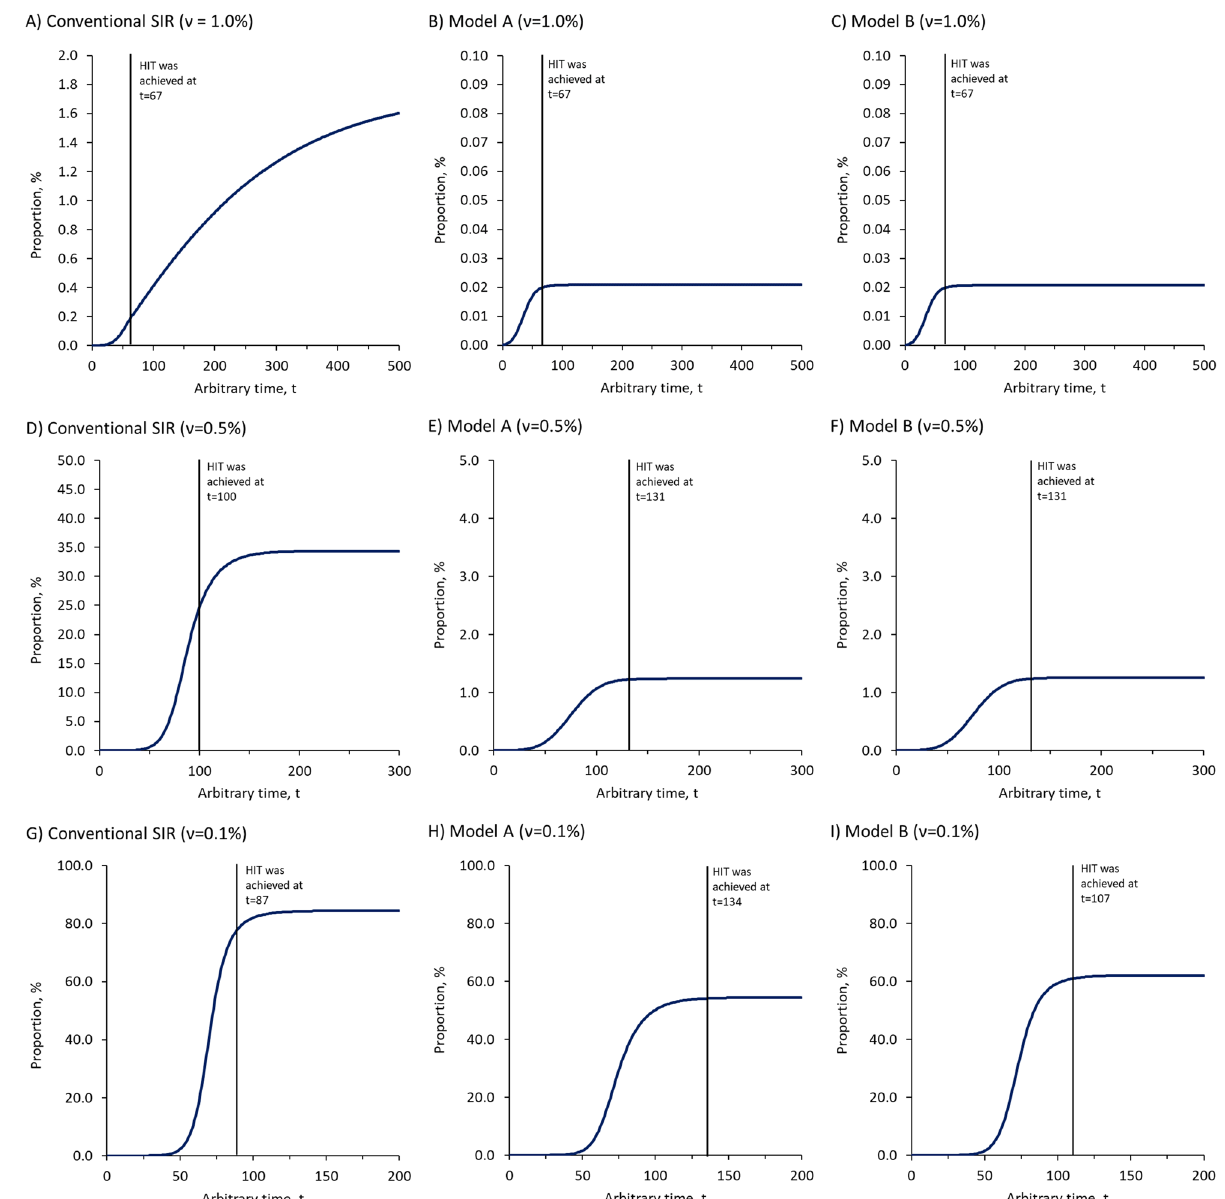
Figure 5. The dynamics of total infections simulated by vaccine models. (A–C) present the dynamics of total infections at vaccination rate, ν = 1.0% population per unit t. The HIT was reached at t = 67 in all three models. (D–F) present the dynamics of total infections at ν = 0.5% population per unit t. The HIT was reached at t = 100 in the conventional SIR model, and at t = 131 in both Model A and Model B. (G–I) present the dynamics of total infections at ν = 0.1% population per unit t. The HIT was reached at t = 87 in the conventional SIR model, at t = 134 in Model A, and t = 107 in Model B. The time to reach the HIT was marked by vertical lines. All data used to create the figures can be sourced at https:// github. com/ willi am81/ newSIR. herd- immun ity. model.